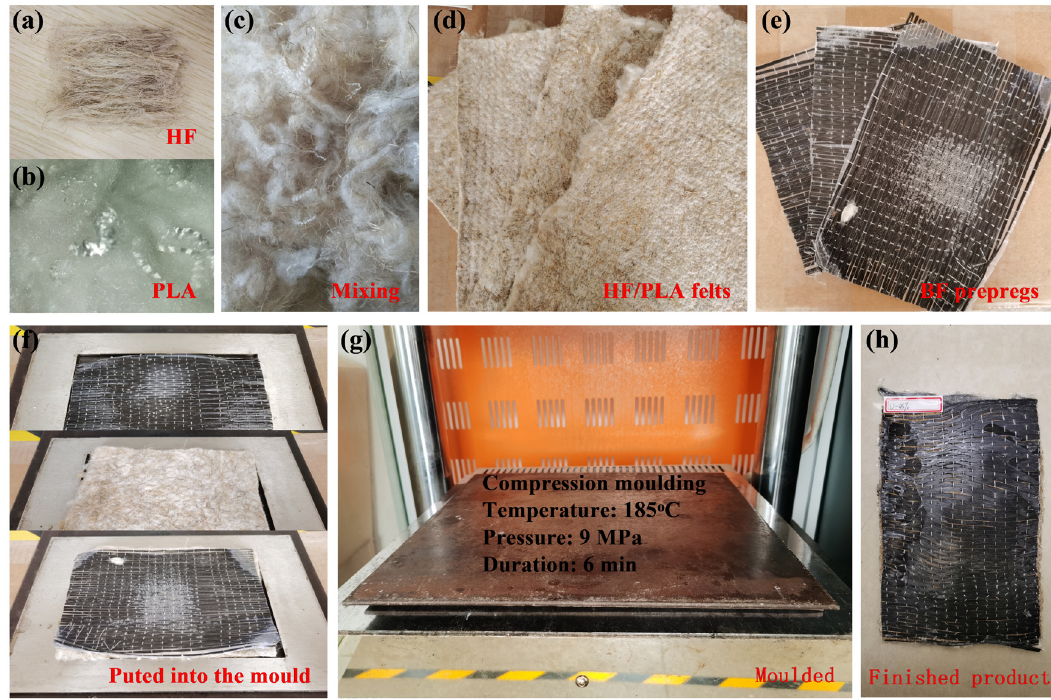
Figure 3: The manufacturing process of